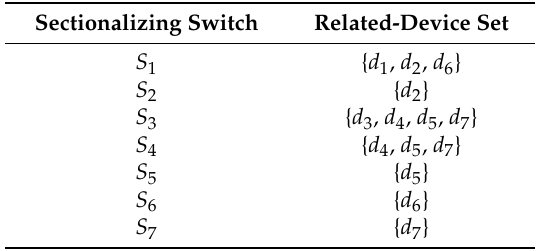
Table 1. Relationship between sectionalizing switches and devices.